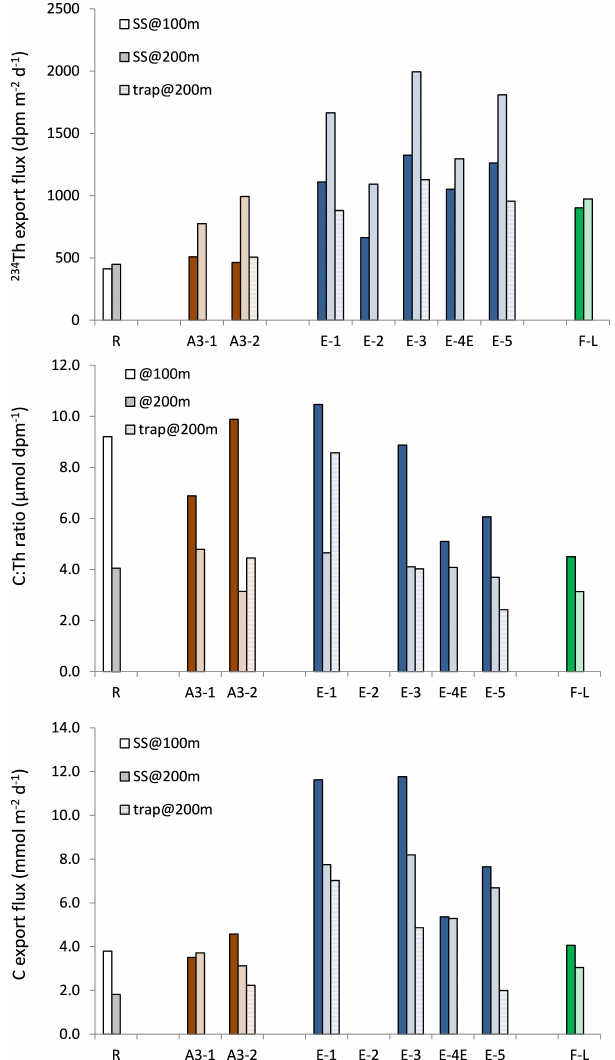
Figure 5. Summary results of 234 Th export fluxes (dpmm − 2 d − 1 ), sinking particles C:Th ratios (µmoldpm − 1 ), and POC export fluxes (mmolm − 2 d − 1 ) obtained at 100 and 200m depth and comparison with sediment trap data obtained at 200m depth during KEOPS2